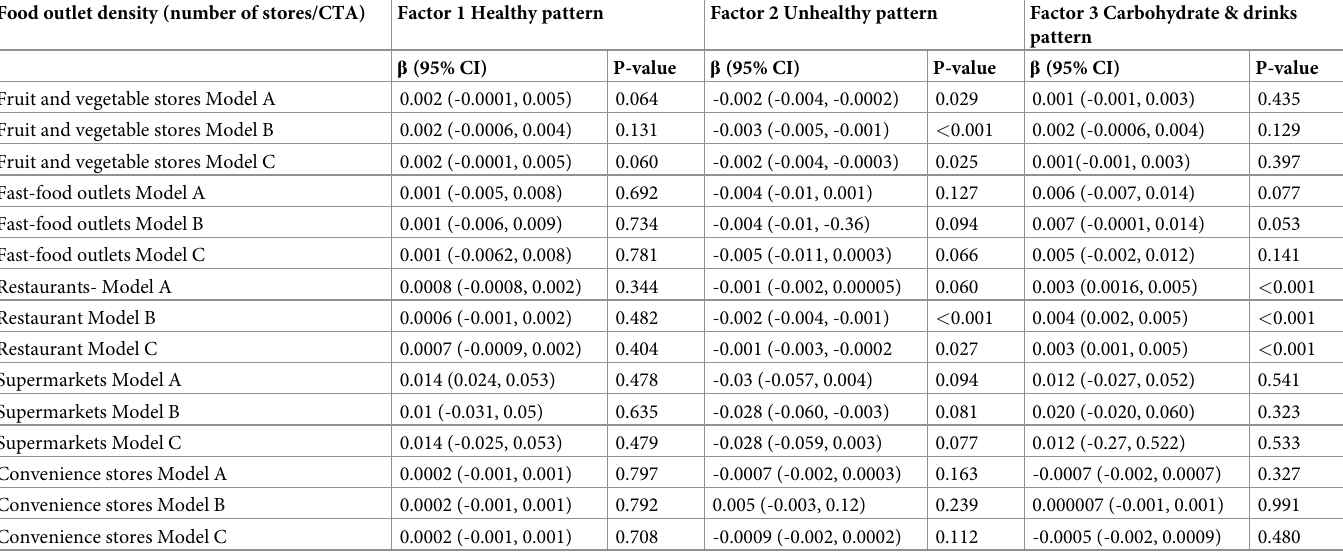
Table 3. Multivariate associations between dietary patterns and food outlet density; data from the nationally representative, cross-sectional, 2012 ENSANUT a — Dietary assessment component. Food outlet density (number of stores/CTA) Factor 1 Healthy